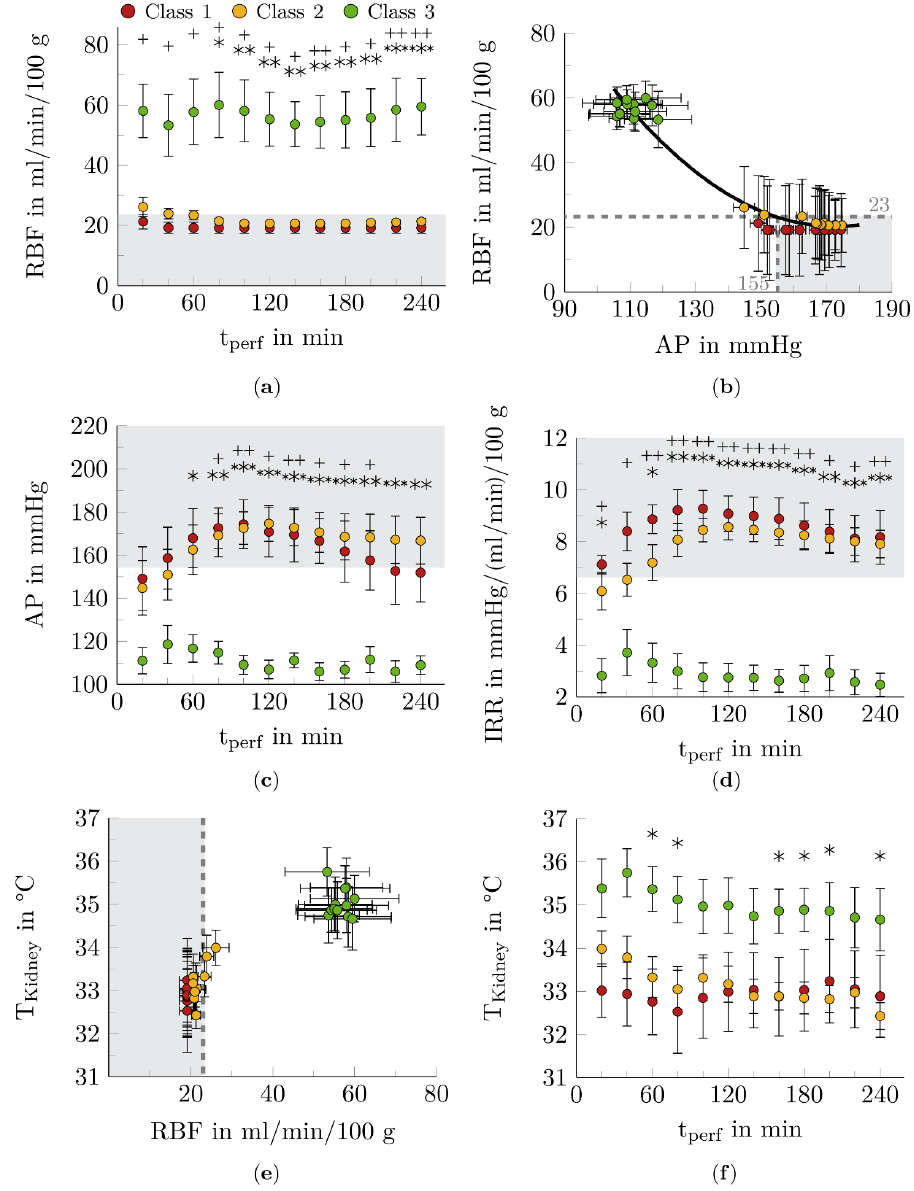
Figure 4. Course of function markers for renal hemodynamic during NMP. A dependency between the predicted functional class and the function markers for hemodynamics could be demonstrated. Kidneys of class 3 behaved significantly different from kidneys of the other two classes regarding renal blood flow (RBF) ( a ), arterial pressure (AP) ( c ) and intrarenal resistance (IRR) ( d ). ( b ) The relationship between AP and RBF was described using a 2nd degree polynomial function (R 2 = 0.96, y = 0.0093x 2 − 3.2127x + 297.6, shown as a black curve). The dependence of T Kidney on RBF ( e ) and kidney function ( f ) was shown. The gray areas illustrate the critical regions of the function markers. The data points represent the twelve times of measurement during the NMP. Shown mean ± SEM. n = 4 for nonfunctional kidneys (class 1), n = 10 for limited functional kidneys (class 2), n = 12 for functional kidneys (class 3), *, p < 0.05, **, p < 0.01, ***, p < 0.001, class 2 vs. class 3; +, p < 0.05, ++, p < 0.01, class 1 vs. class